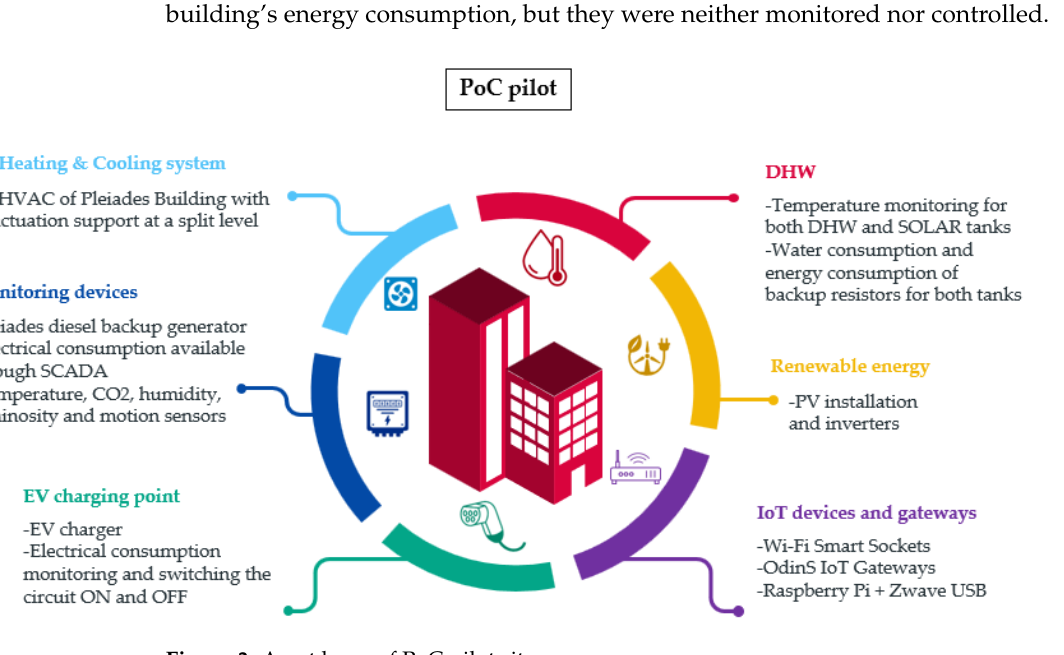
Figure 4. Implementation of PHOENIX architecture in PoC. To ensure and support the deployment of the intervention and to validate the suc- cessful demonstration of the PoC’s KPIs, a trial plan was defined (Table 3). Table 3. PoC’s trial definitions.